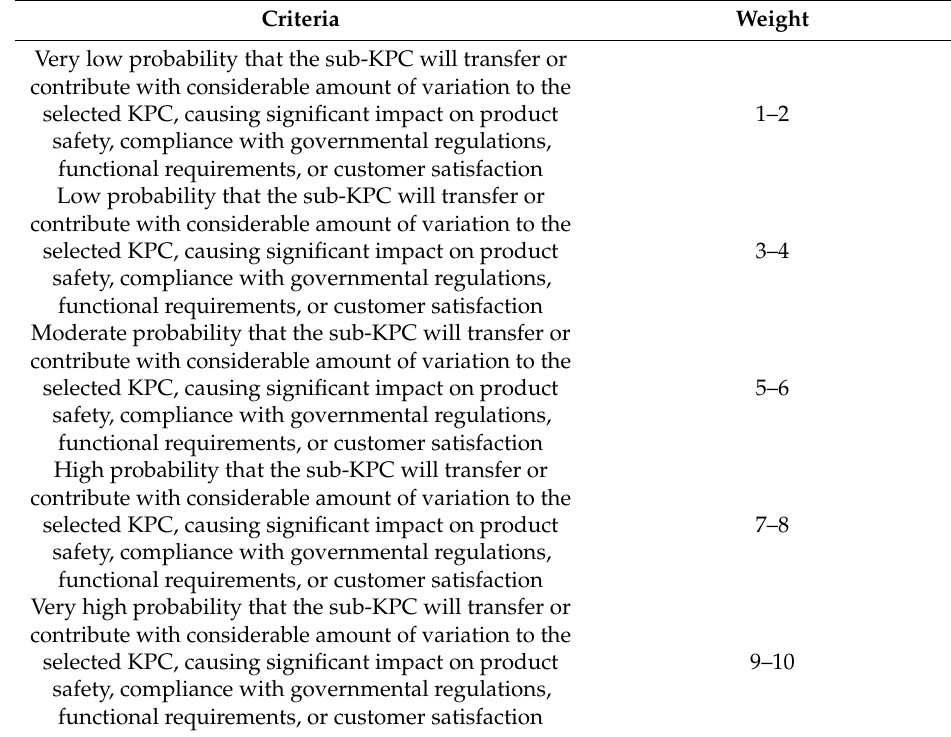
Table 3. Criteria for assessing the transfer of variation from Sub-KPC to KPC [32]. Criteria